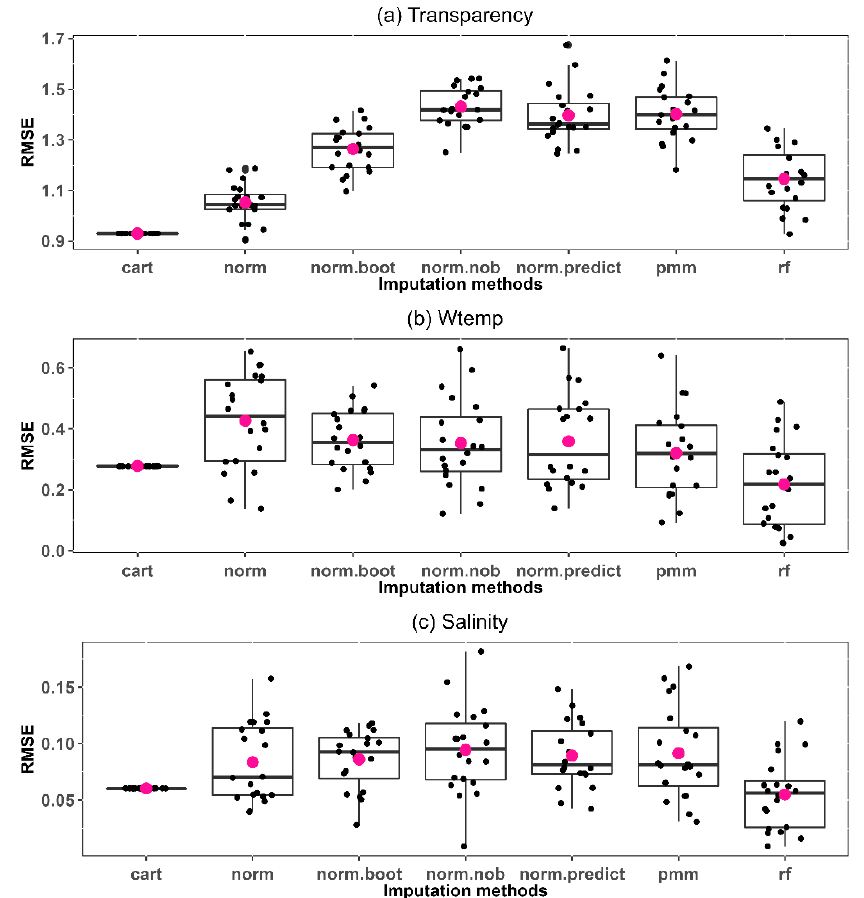
Figure 6. RMSE distribution for transparency, water temperature, and salinity. ( a ) transparency; ( b ) water temperature; ( c ) salinity. The central lines in the boxes represent the median, and the boxes encompass data between the 25th and 75th percentile; whiskers span the 5th and 95th percentiles. The black circles of each boxplot represent RMSE values. The dark pink circles in the boxes represent the means. Abbreviations: pmm, predictive mean matching; norm, Bayesian linear regression; norm.nob, linear regression ignoring model error; norm.boot, linear regression using bootstrap; norm.predict, linear regression, predicted values; cart, classification and regression trees; rf, random forest imputations [36].